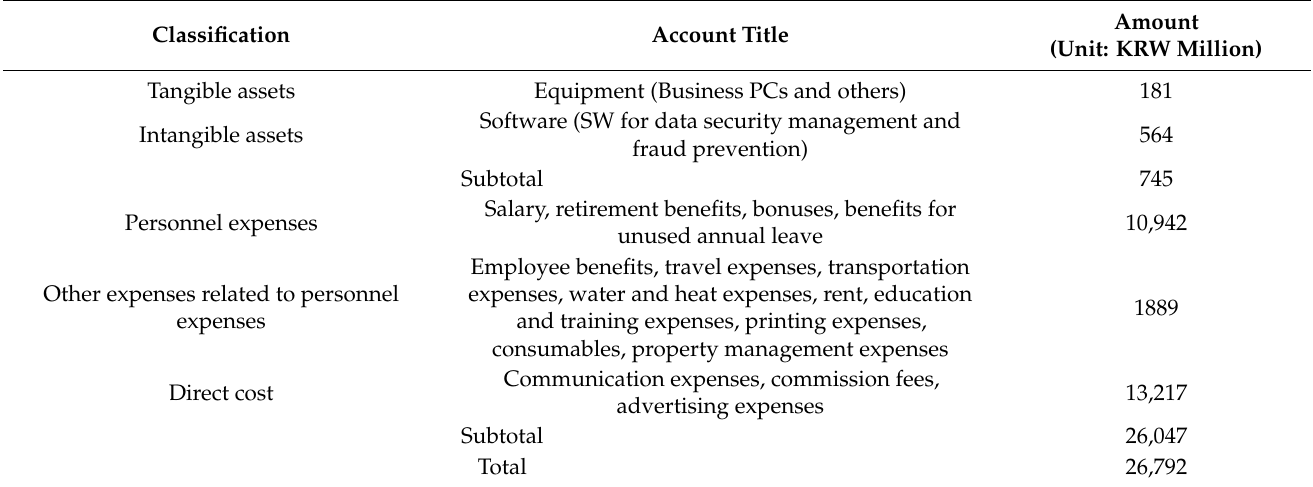
Table 11. Result of data value calculation based on cost approach after reflecting economic